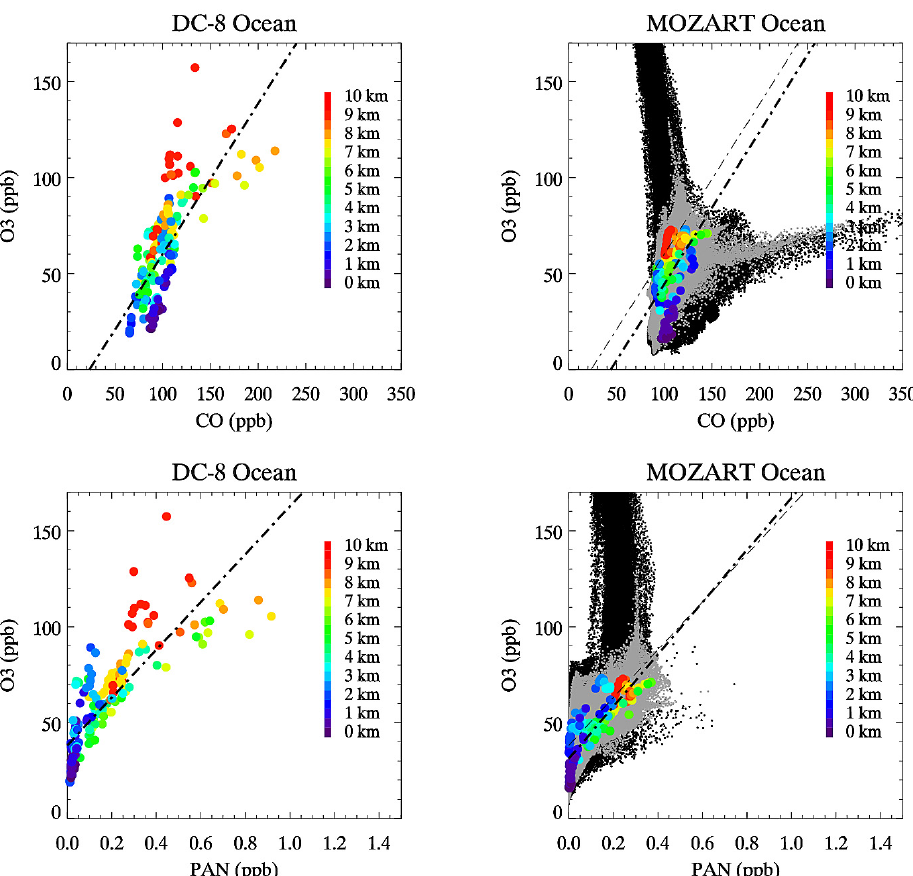
Fig. 3. Observed and modeled O 3 -CO and O 3 - PAN relationships for the aircraft path and respective larger regions. Aircraft data are color-coded by altitude as shown in legend. Larger region data (AVGRegionTime) are in black and gray with lighter shades indicating free tropospheric data (altitudes between 2–8km). For illustration purposes, a 2-sided linear regression line to the flight track data is added to the graphs. The thin line in the MOZART plots (right-hand side) is a repeat of the fit to the aircraft